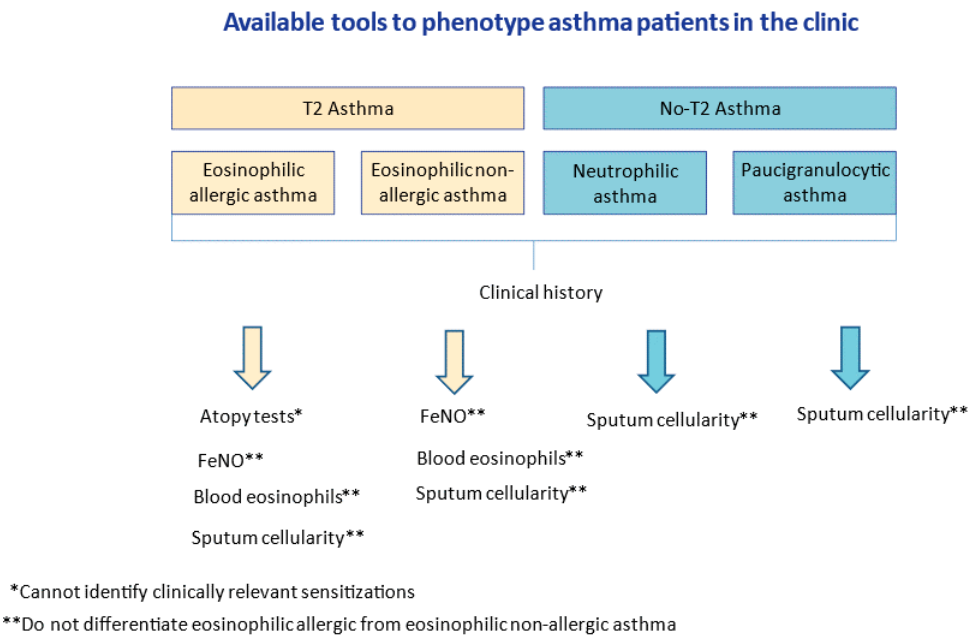
Figure 1. Description of asthma phenotypes, and utility of currently available biomarkers for the confirmation of allergic asthma in the clinic. FeNO: fractional exhaled nitric oxide; T2: type 2 inflam- mation.